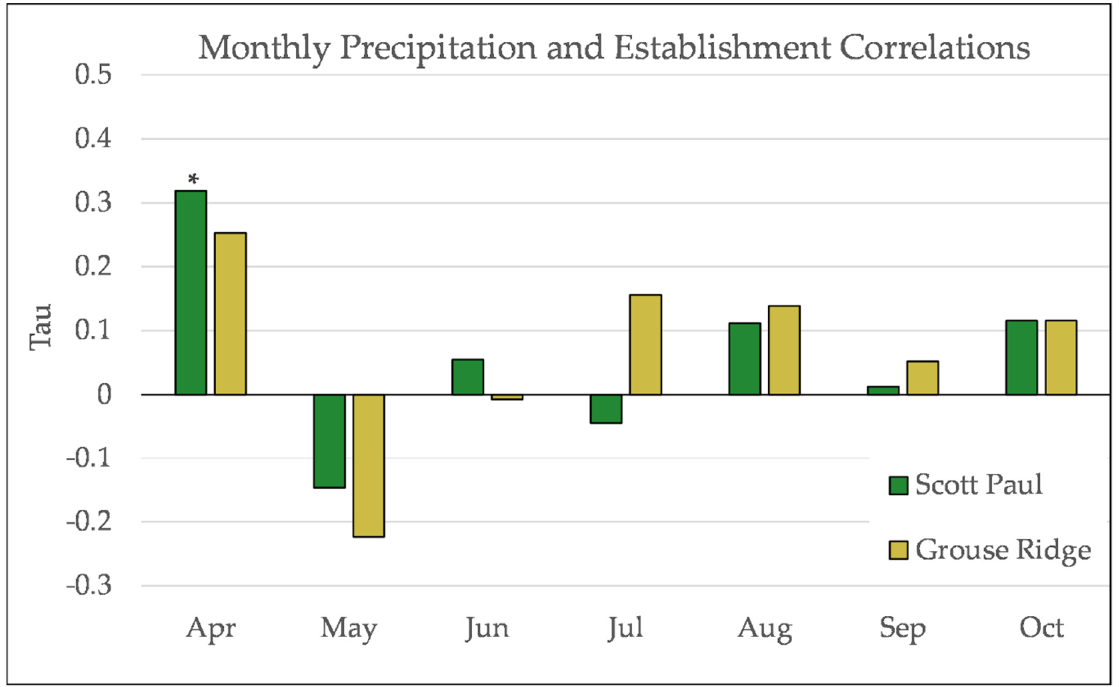
Figure 7. Partial Kendall’s correlation between mean monthly precipitation and establishment at the both sites. * = p -Value < 0.05.